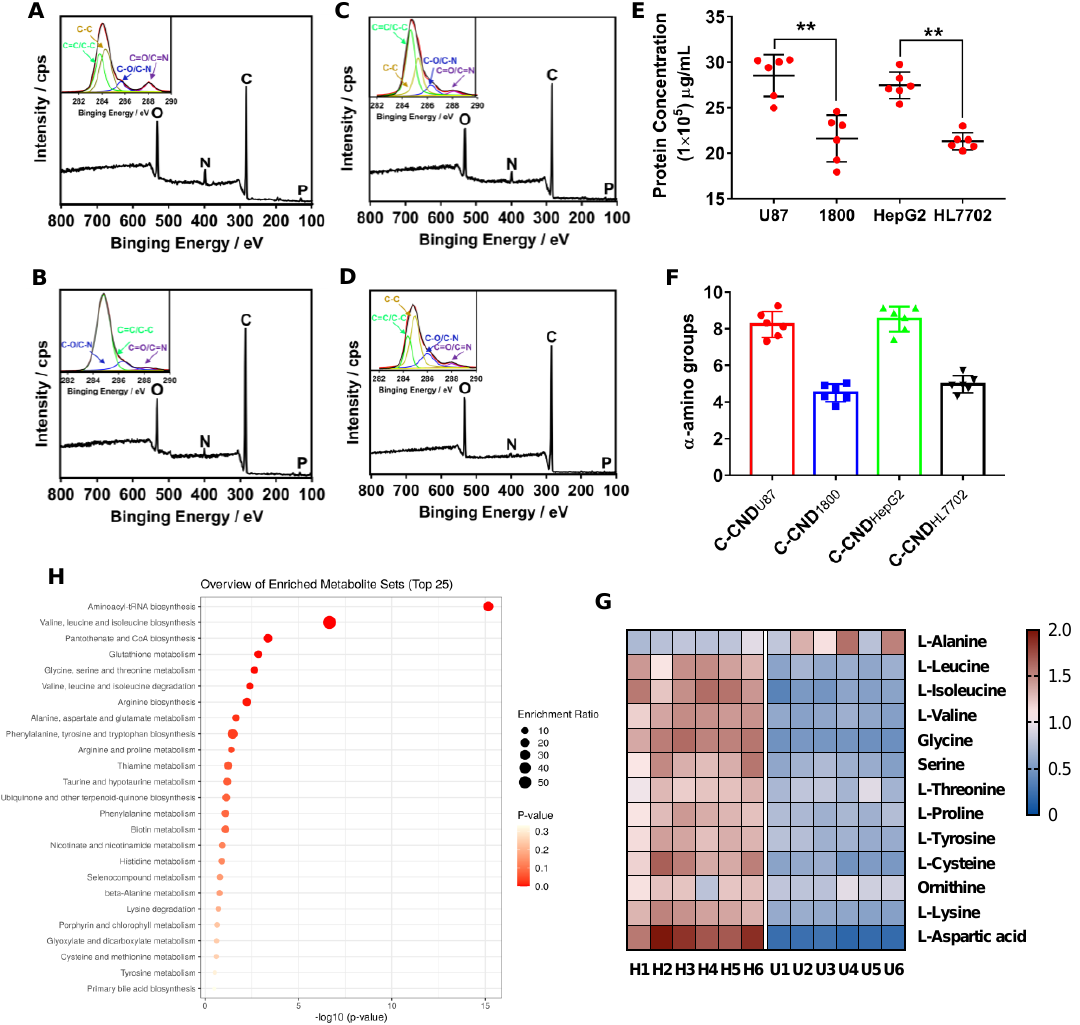
Figure 2. XPS patterns of: ( A ) C-CND U87 , ( B ) C-CND 1800 , ( C ) C-CND HepG2 , and ( D ) C-CND HL7702 . Insert: P1s spectra of corresponding C-CND . ( E ) BCA assay of the total protein content of different types of cells. Data are represented as mean ± SD ( n = 6). ( F ) The number of α -amino groups on the different C-CND. Data are represented as mean ± SD ( n = 6). ( G ) The amino acid analysis in cancer cell lysates, H: HepG2 cell, U: U87 cell. ( H ) The metabolic pathways associated with amino acids of Figure 2G. Notes: ** p < 0.01.